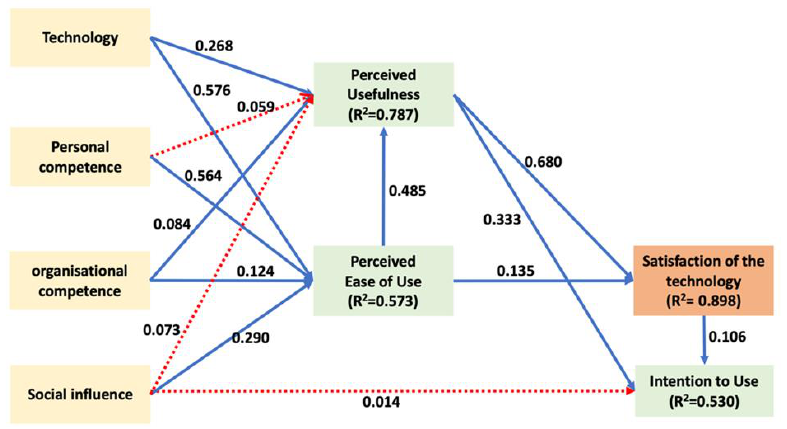
Figure 3. Results of hypothesis testing.